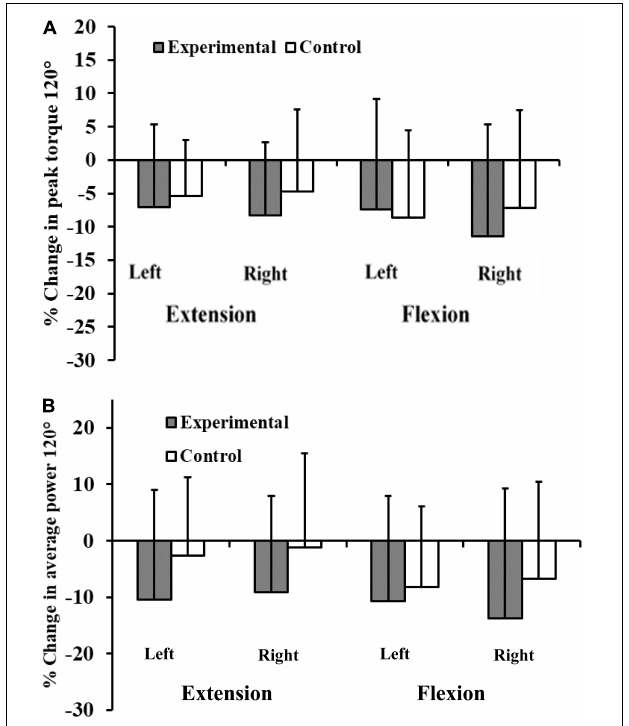
FIGURE 6 | Percentage change in peak torque 120 ◦ (A) and average power (B) for experimental and control subjects after participation of experimental subjects in the 8-week plyometric training